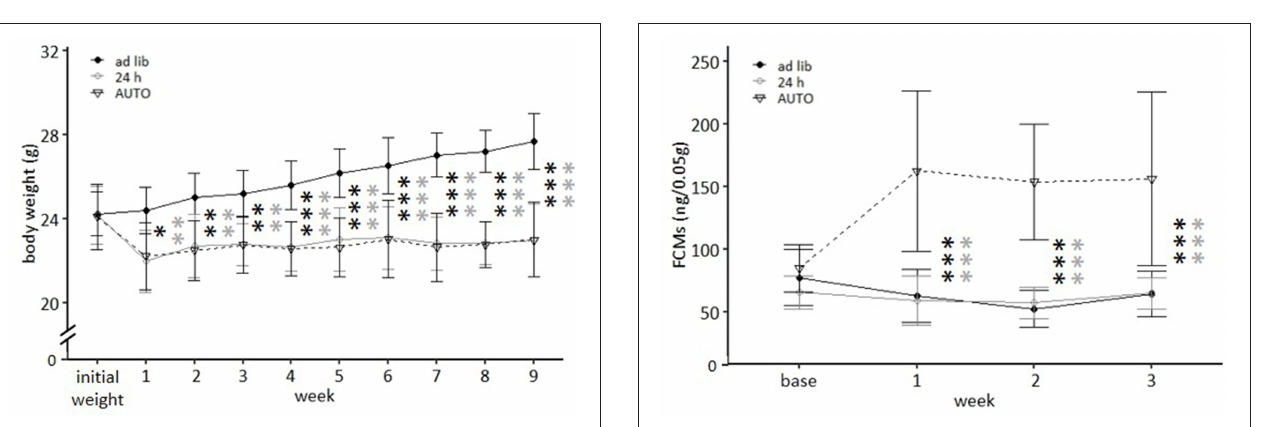
FIGURE 8 | Levels of fecal corticosterone metabolites (FCMs). Base, Baseline; ad libitum feeding for all groups. Ad lib , Ad libitum group; 24h, 24h schedule group; AUTO, Automated feeding routine group. Data presented as means ± SD. Statistics, repeated measures ANOVA; Post hoc , Bonferroni-Holm corrected); sample size: n = 12 per group; *** p < 0.001. Gray asterisks: comparison ad lib and 24h, black asterisks: comparison ad lib and